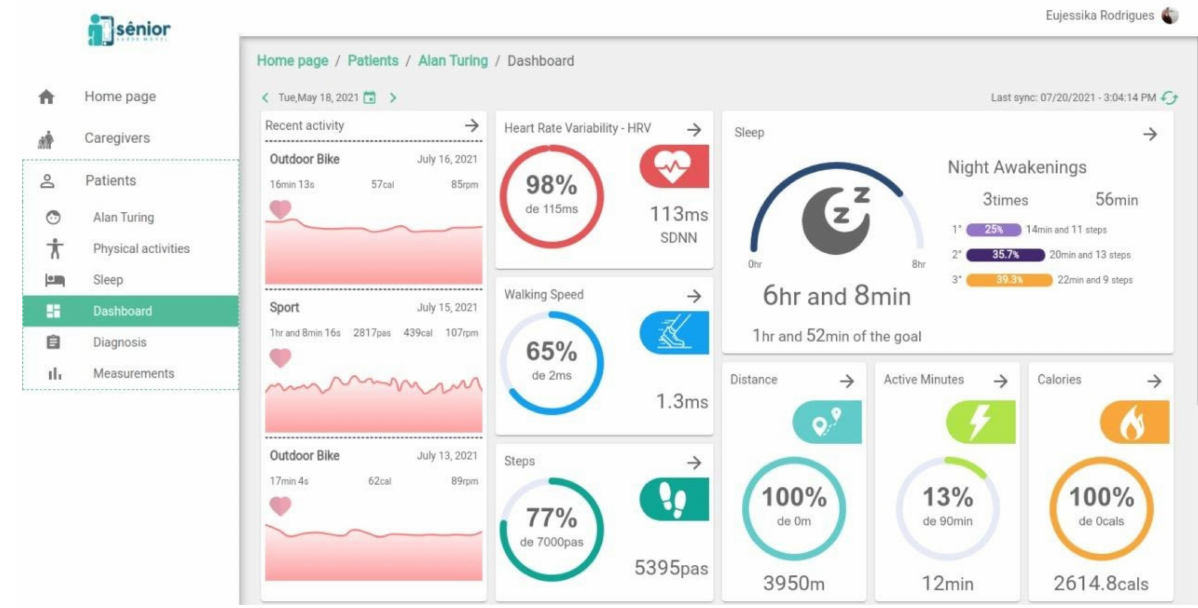
Figure 2. Overview of the SMH web